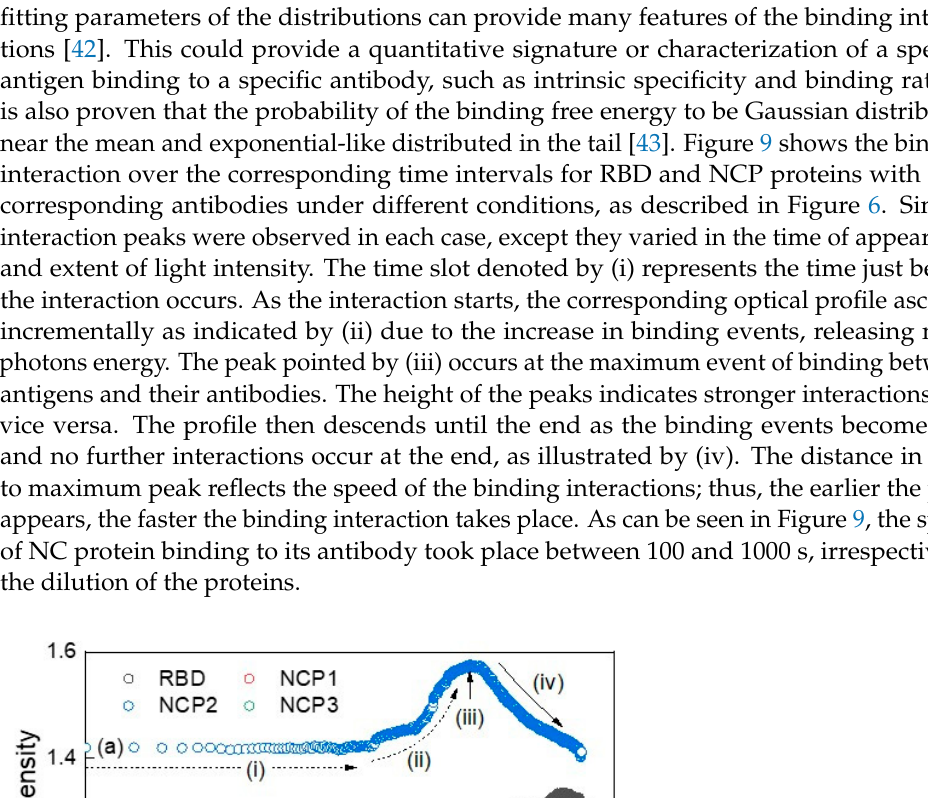
Table 2. Fitting parameters for interaction profiles depicted in Figure 9.